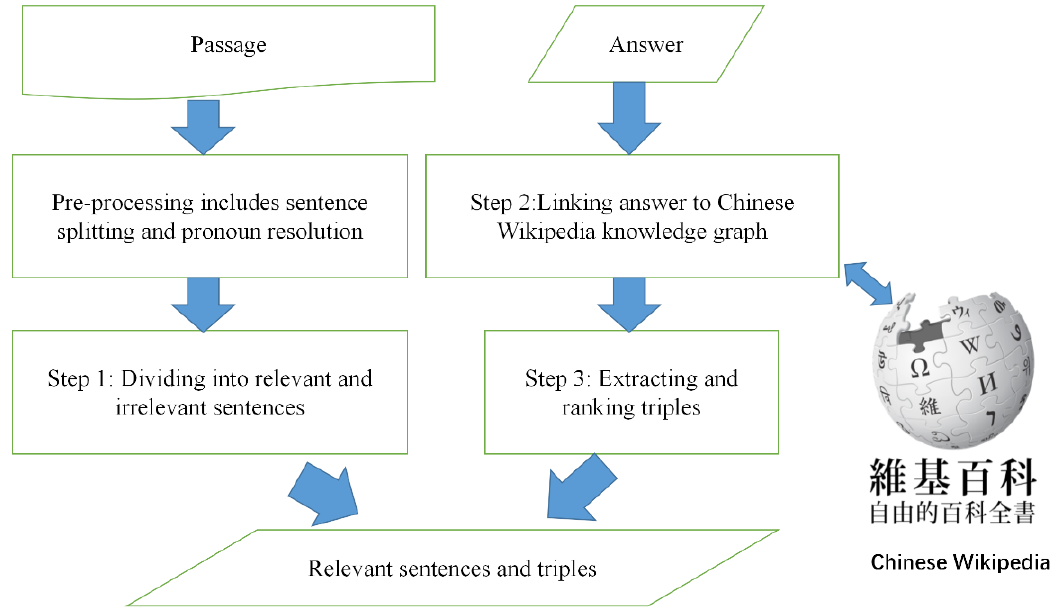
Figure 1. Passage Compression and Knowledge Argumentation Steps